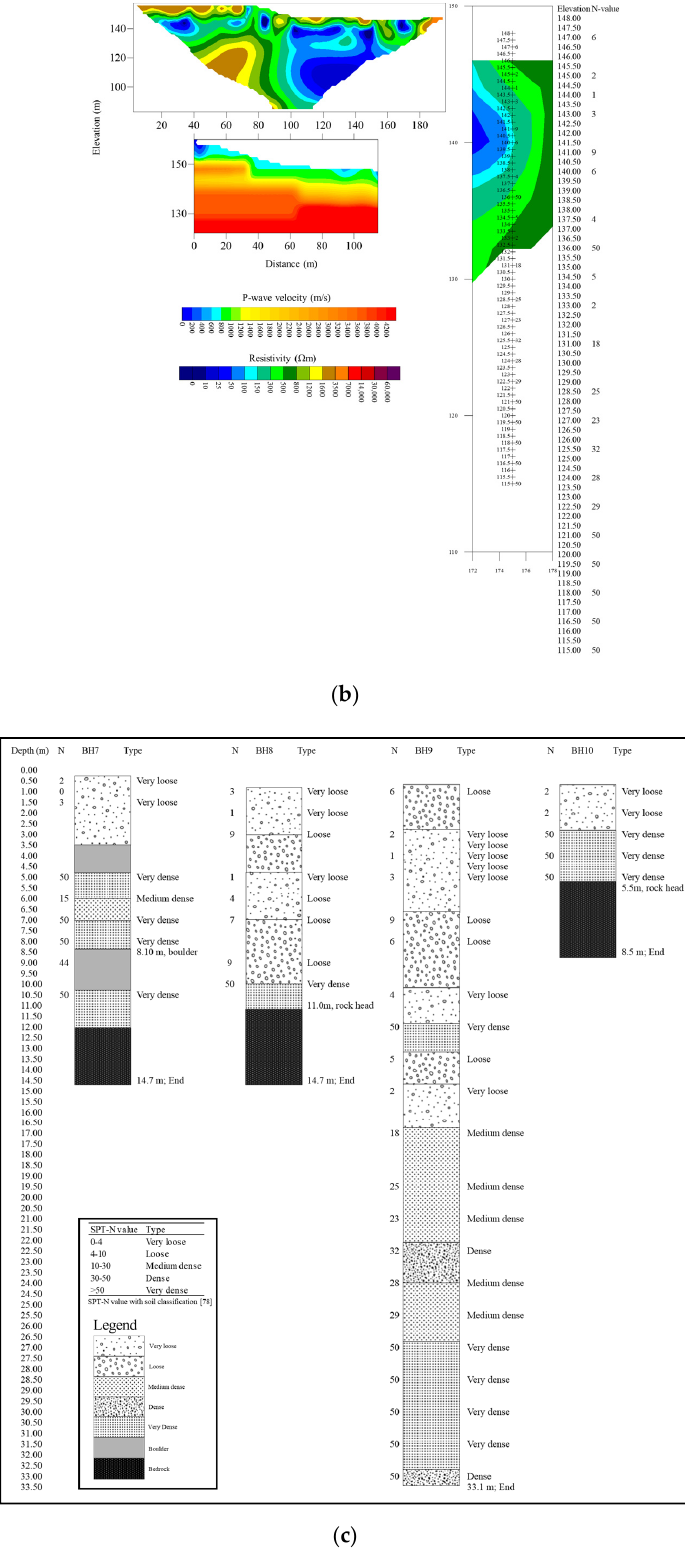
Figure 9. Correlated results of geophysical and borehole investigation: ( a ) line HR1 and HS1 with BH10; ( b ) line HR1 and HS2 with BH9; ( c ) schematic geological profile based on the N -value of Standard Penetration Test (SPT) distribution from borehole of BH7, BH8, BH9, and